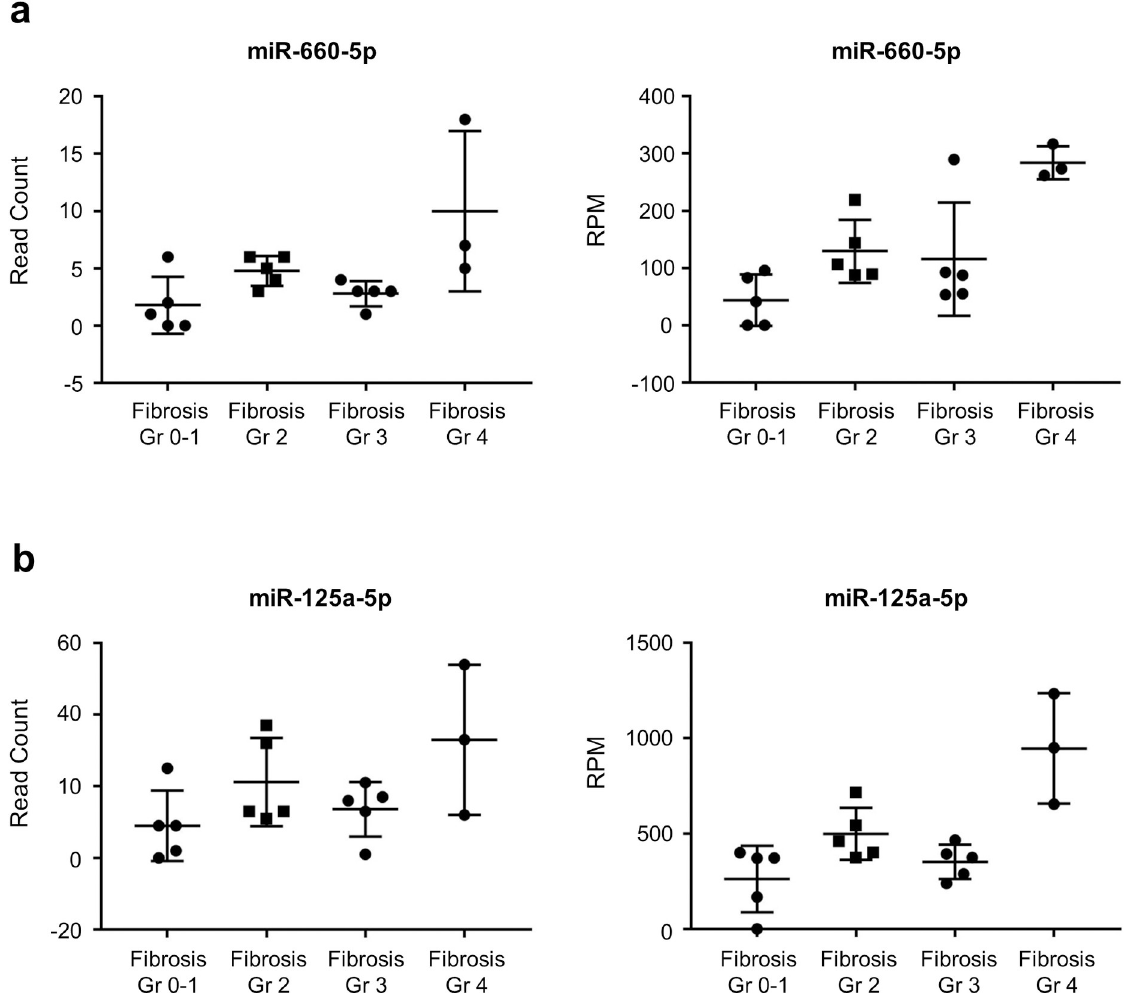
Fig 1. Both miR-660-5p and miR-125a-5p are differentially expressed in each fibrosis stage. Read counts and reads per million counts (RPM) by NGS according to liver fibrosis stages of (a) miR-660-5p and (b)